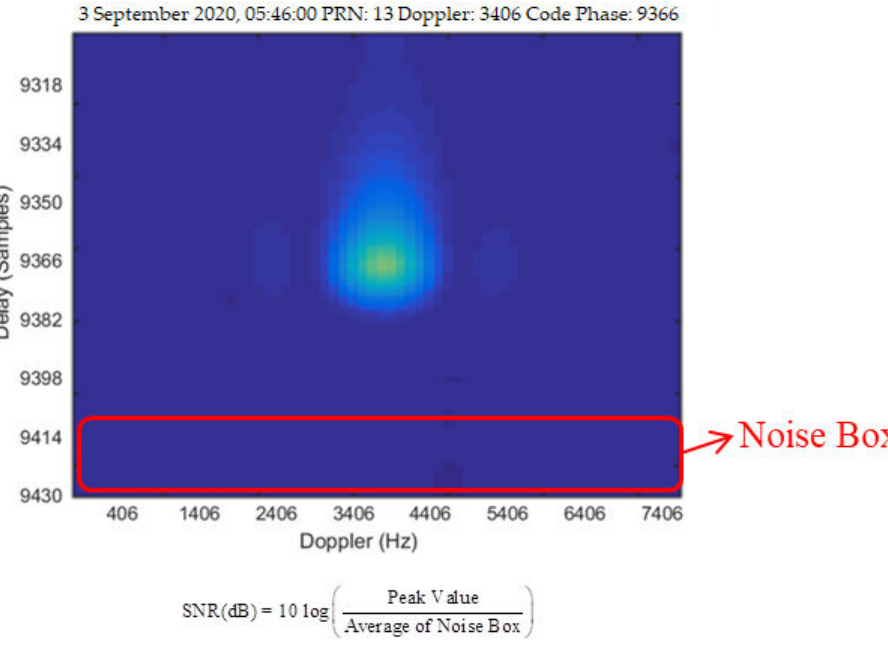
Figure 16. A signal-to-noise ratio (SNR) calculation of